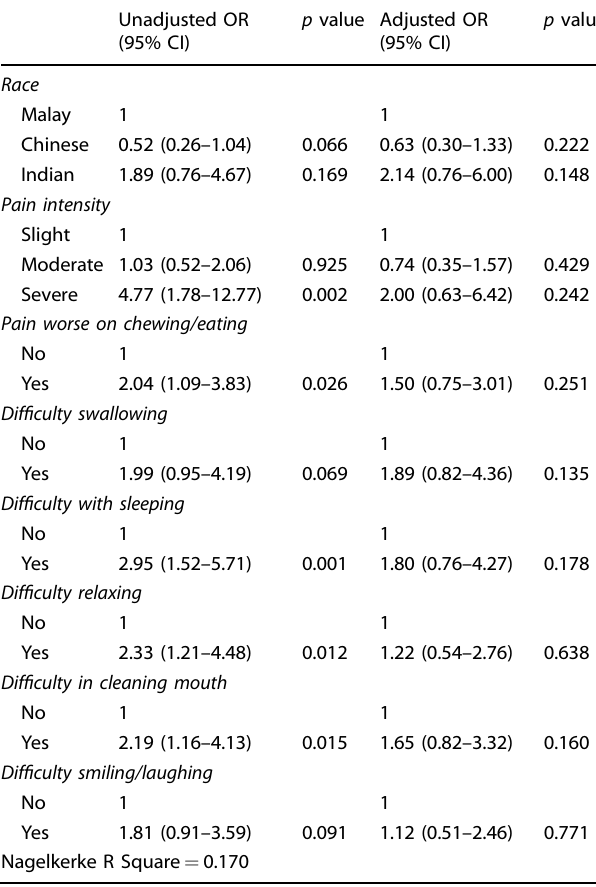
The fi nding that racial differences in the tooth pain experience